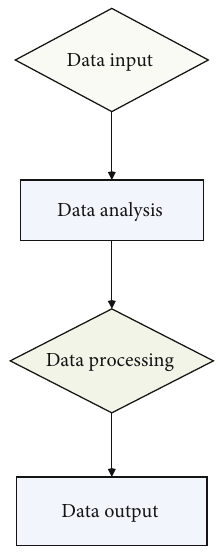
Figure 1: Data processing